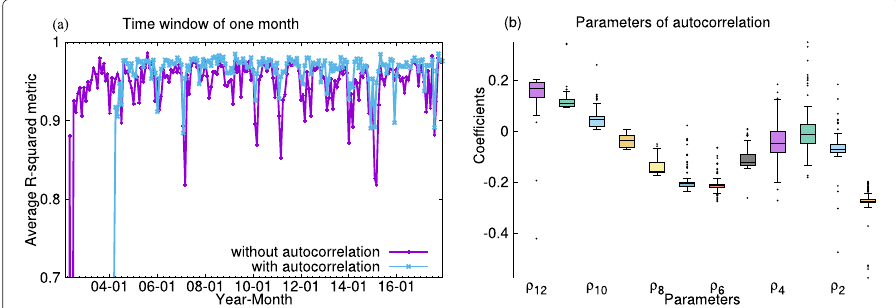
Fig. 4 Autocorrelation correction for one-month predictions. a The fluctuations of performance are smaller for the predictions with autocorrelation for all lengths of historical data. b The coefficients of parameters of previous 12 months errors in the